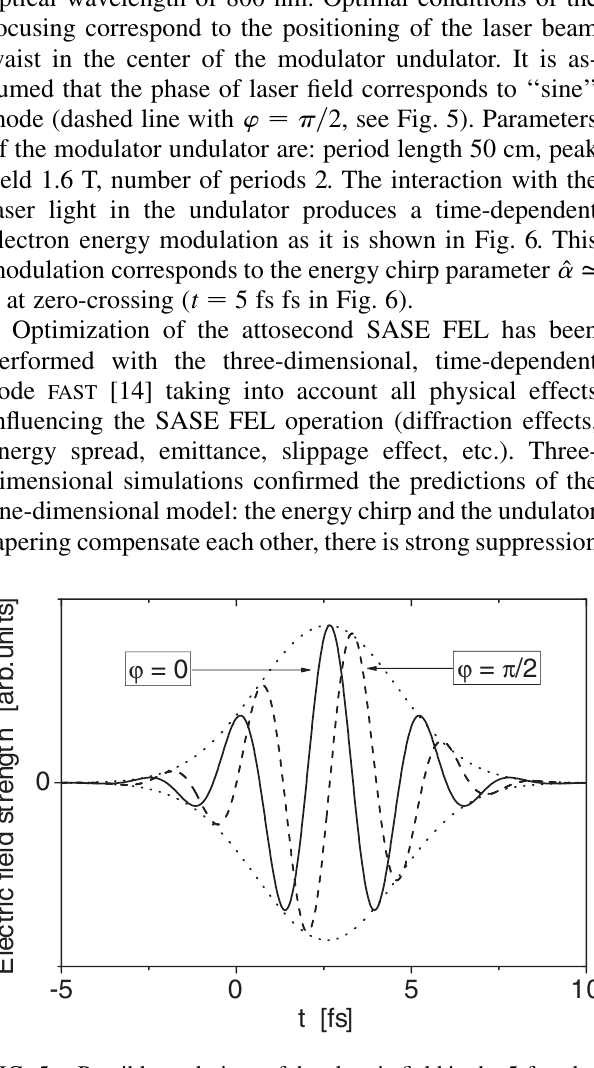
FIG. 6. Energy modulation of the electron beam at the exit of the modulator undulator (dotted line) and a profile of the radiation pulse at the undulator length 100